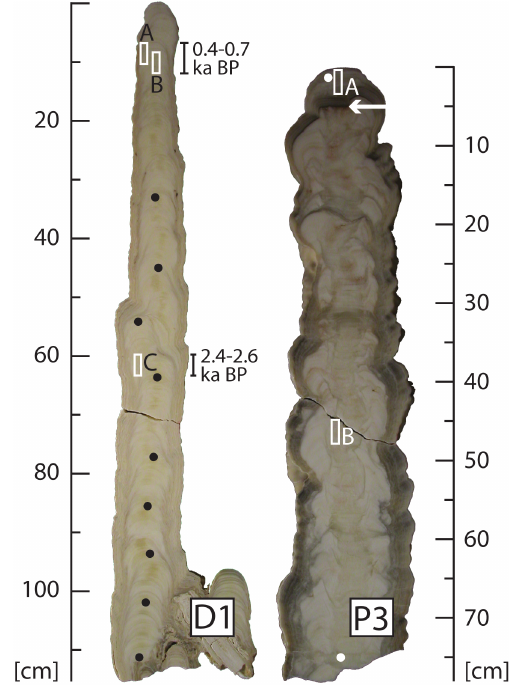
Fig. 2. Photographs of polished sections of stalagmites D1 and P3 cut parallel to their growth axes including locations for 230 Th dat- ing (black dots for D1, white dots for P3). The arrow points to a potential growth hiatus in stalagmite P3. White squares indicate ar- eas from which thin sections for stalagmite D1 (D1-A, -B, -C) and P3 (P3-A, -B) were prepared. For D1 sections also the covered time intervals are given. Photographs for Y99 with locations for dating are presented in Fleitmann et al.